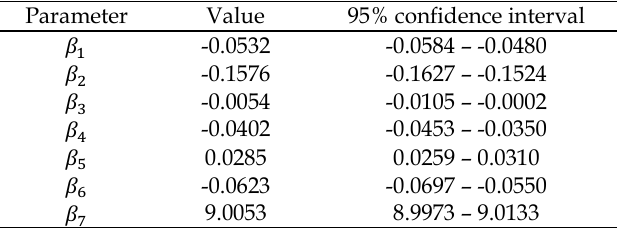
Deterministic parameters calculated with data on daily